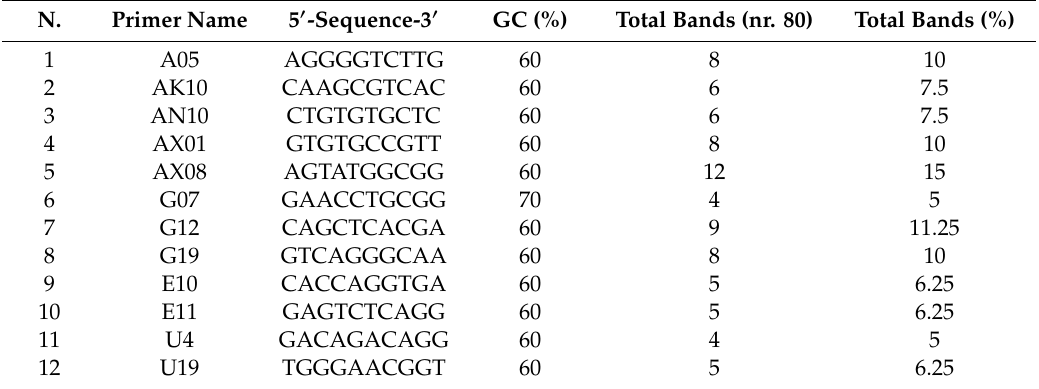
Table 6. Arbitrary 10-mer primers used for RAPD analysis of Neapolitan limmo and lemoncetta Locrese.